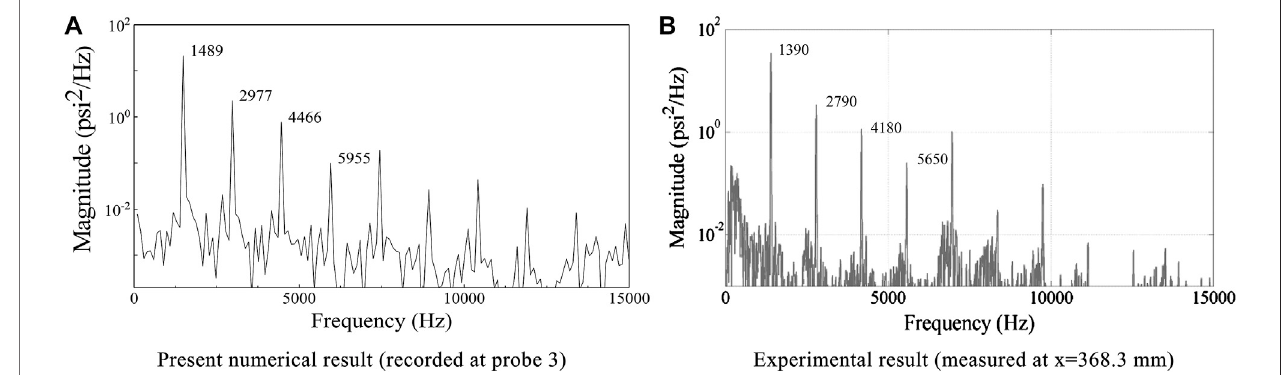
FIGURE 6 | Comparison of PSD analysis between numerical results and experimental (Yu et al., 2012) data. The relative error between computed dominant frequency(1,489 Hz)andexperimental result(1,390 Hz)iswithin7.2%,and thatforpressureoscillationsis19.2%. (A) Presentnumericalresult(recorded atprobe3) (B) Experimental result (measured at x = 368.3